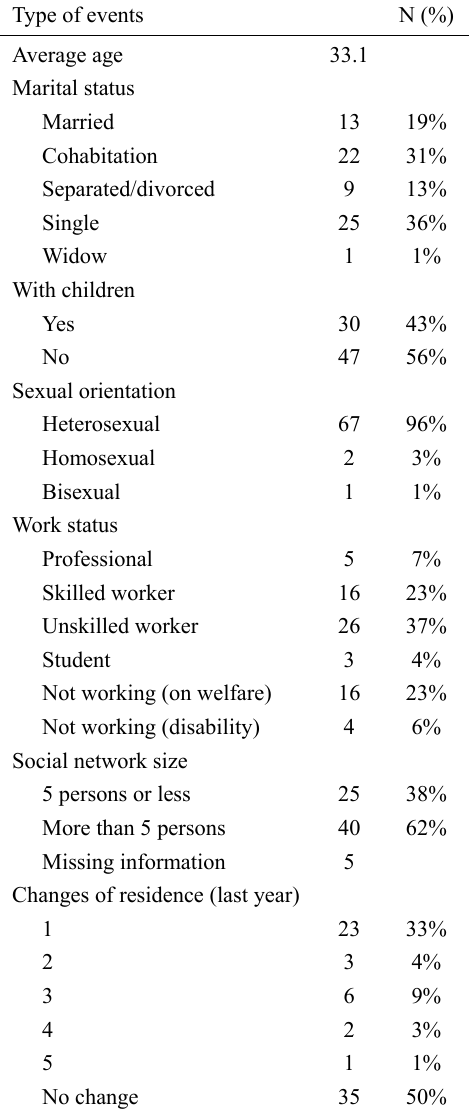
Table 1. Sociodemographic